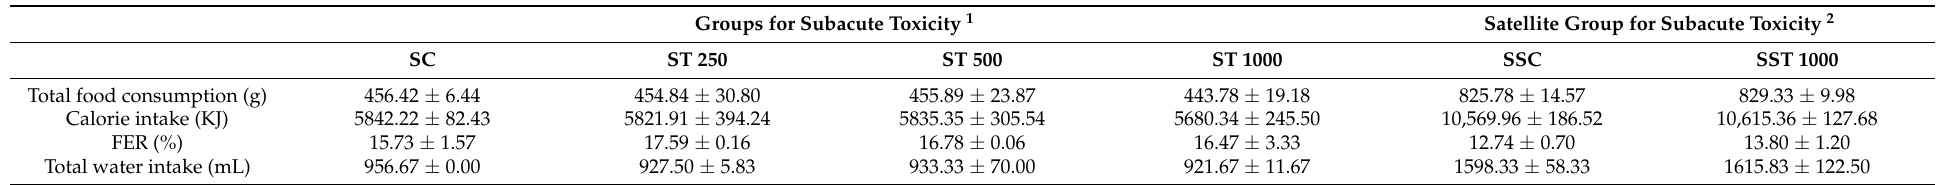
Table 8. Total food consumption, caloric intake, FER, and total water consumption in the subacute toxicity study. Values are expressed as mean ± SEM.